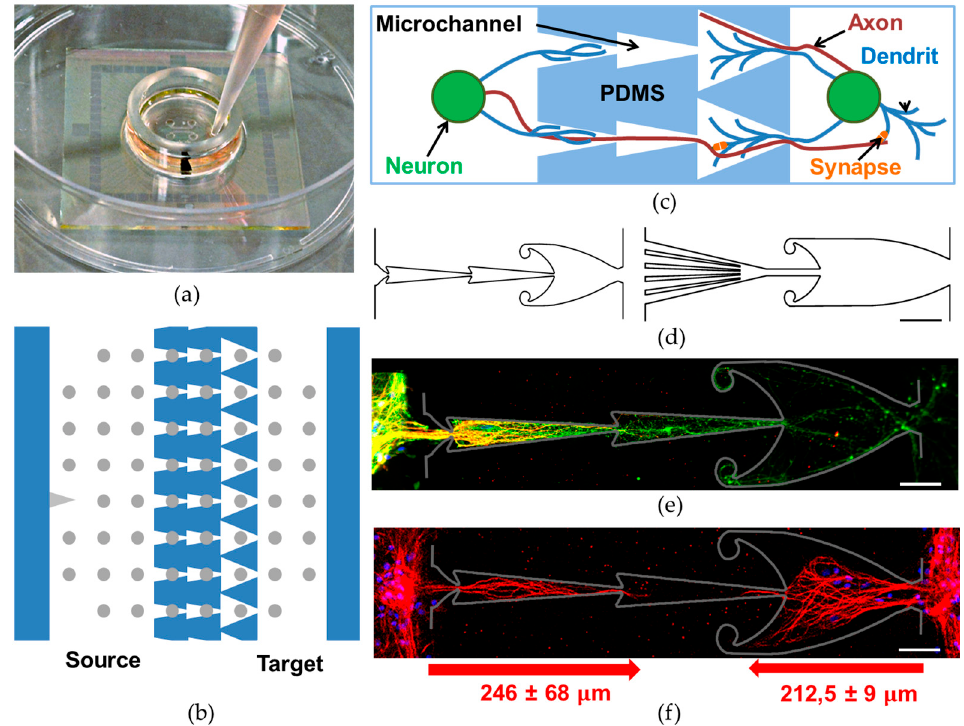
Figure 1. PDMS chip to grow modular neural networks. ( a ) Microelectrode array mounted with microfluidic PDMS chip. ( b ) Schematic view of the microfluidic device mounted to the MEA, with 16 micro-channels connecting the two chambers. Microchannel length was 600 µ m in the Fish chip and 700 µ m in the Octopus chip. ( c ) Specific microchannel structure provides unidirectional neurite growth. ( d ) Schematic view of microchannels in the Fish chip (on the left) and the Octopus chip (on the right), scale bar 100 µ m. ( e , f ) Immunofluorescence images from a hippocampal culture at 21 DIV only in the Source chamber: neurons (b3-tubulin, green), neuronal somas and dendrites (Map2, red) and cell nuclei (DAPI, blue) ( e ) and in both the Source and the Target chambers—neuronal somas and dendrites (Map2, red) and cell nuclei (DAPI, blue), scale bar 50 µ m ( f ). Chips were removed. Gray lines indicate the manually marked previous locations of the microchannel boundaries. The arrows below indicate the average length of dendrites growing from the Source and the Target